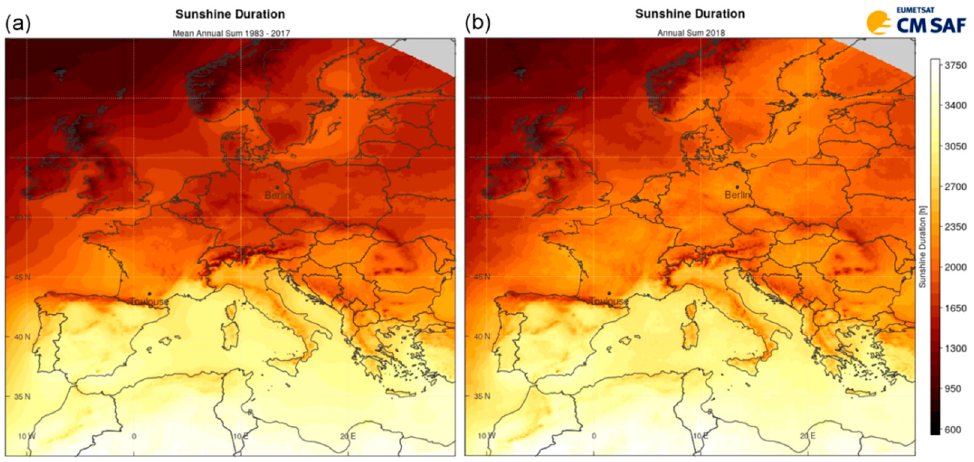
Figure 5. Sunshine duration mean annual sum for the time period 1983 to 2017 ( a ) and for the year 2018 ( b ). The cities of Berlin and Toulouse are highlighted.